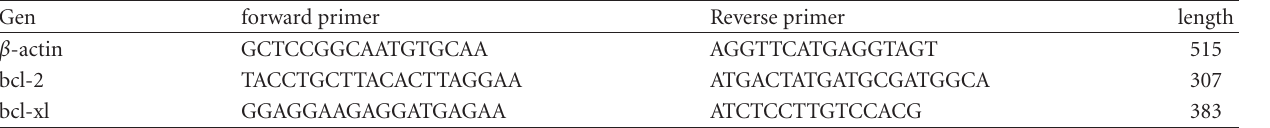
Table 3: Bcl-2/Bax and Bcl-xl/Bax expression ratios in SMC cul- tures: Bcl-2/Bax and Bcl-xl/Bax expression ratios in SMC cultures at baseline (SMC-C, SMC-Ch, and SMC-Ch-FO) and Bcl-2/Bax